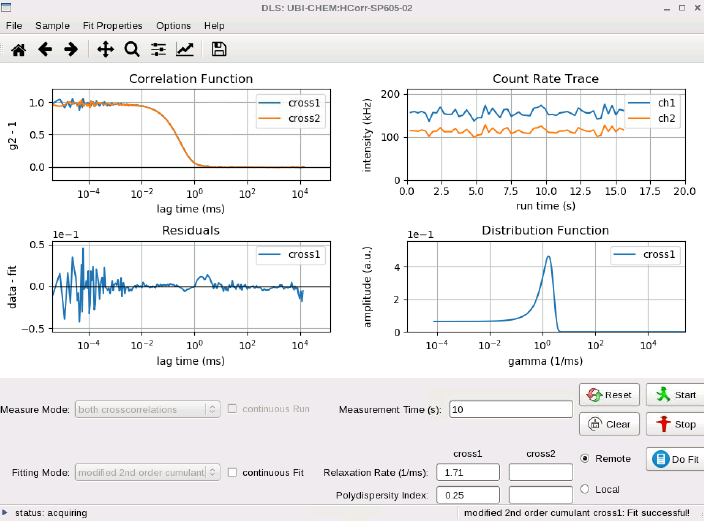
Figure 9. Application for controlling and monitoring the fits of the data during the